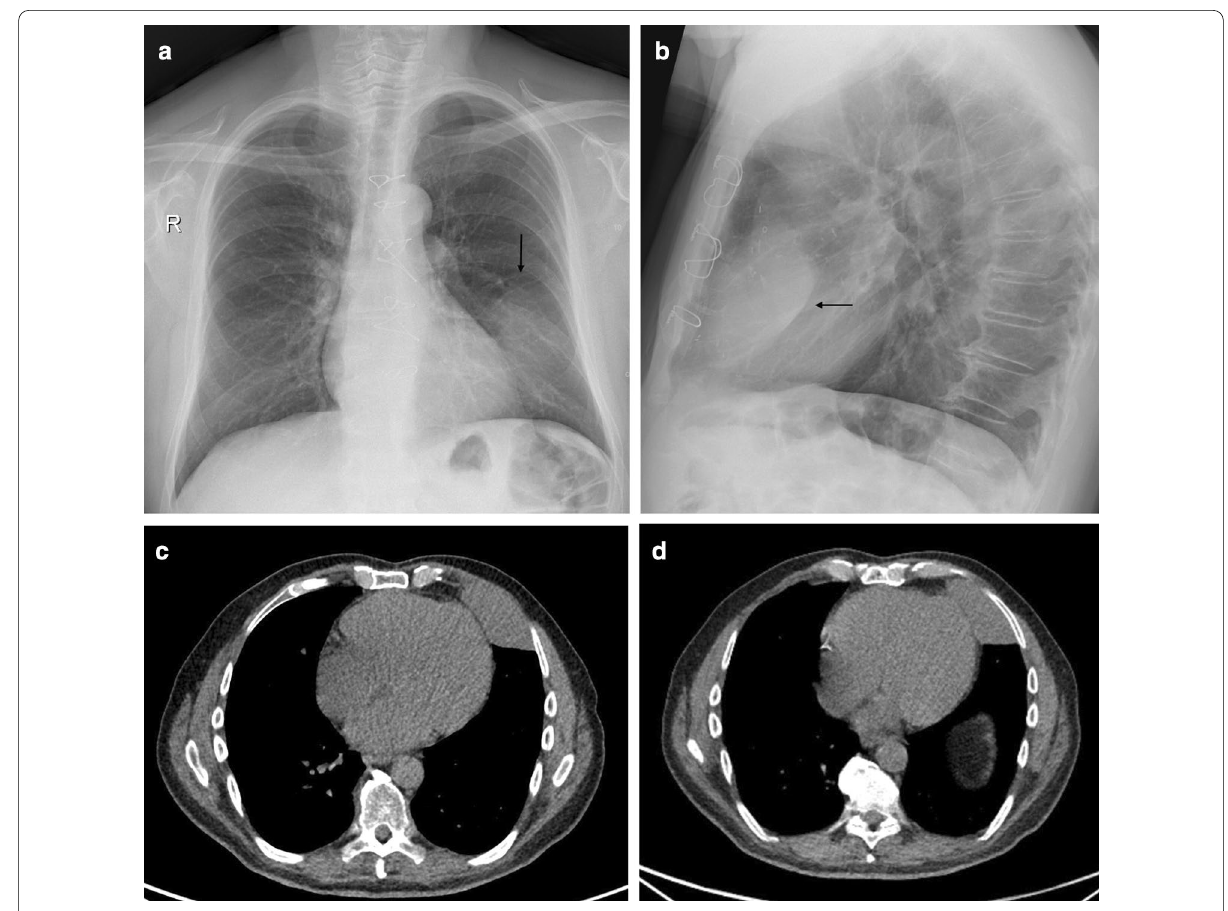
Fig. 6 Diagnosis: desmoid tumor. Technique: standard chest radiography and chest CT. Description: A 76-year-old man (never smoker) presented with dyspnea and chronic cough. Postero-anterior and lateral chest radiographs ( a , b ) show a relatively ill-defined area of consolidation (arrow) in the left lung (lingular region). Axial non-contrast-enhanced CT ( c , d ) shows a relatively well-defined oval-shaped pleural-based mass, isodense to muscle. There are no signs of associated chest wall involvement. Diagnosis of a desmoid tumor was made after surgical resection